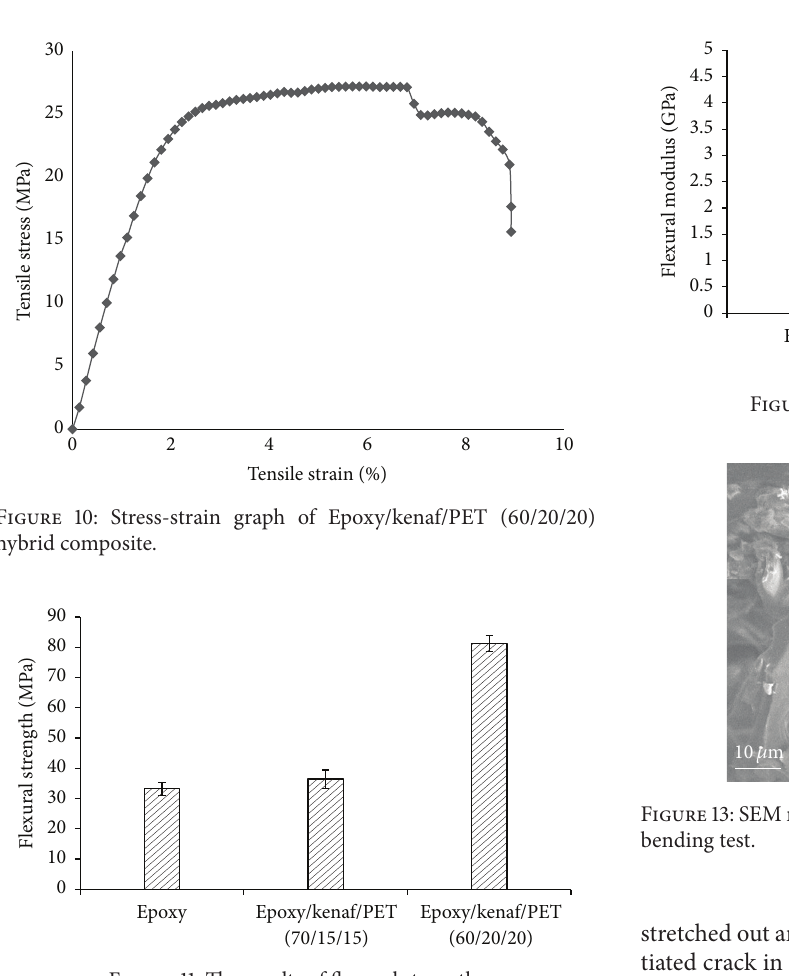
Figure 11: The results of flexural strength.